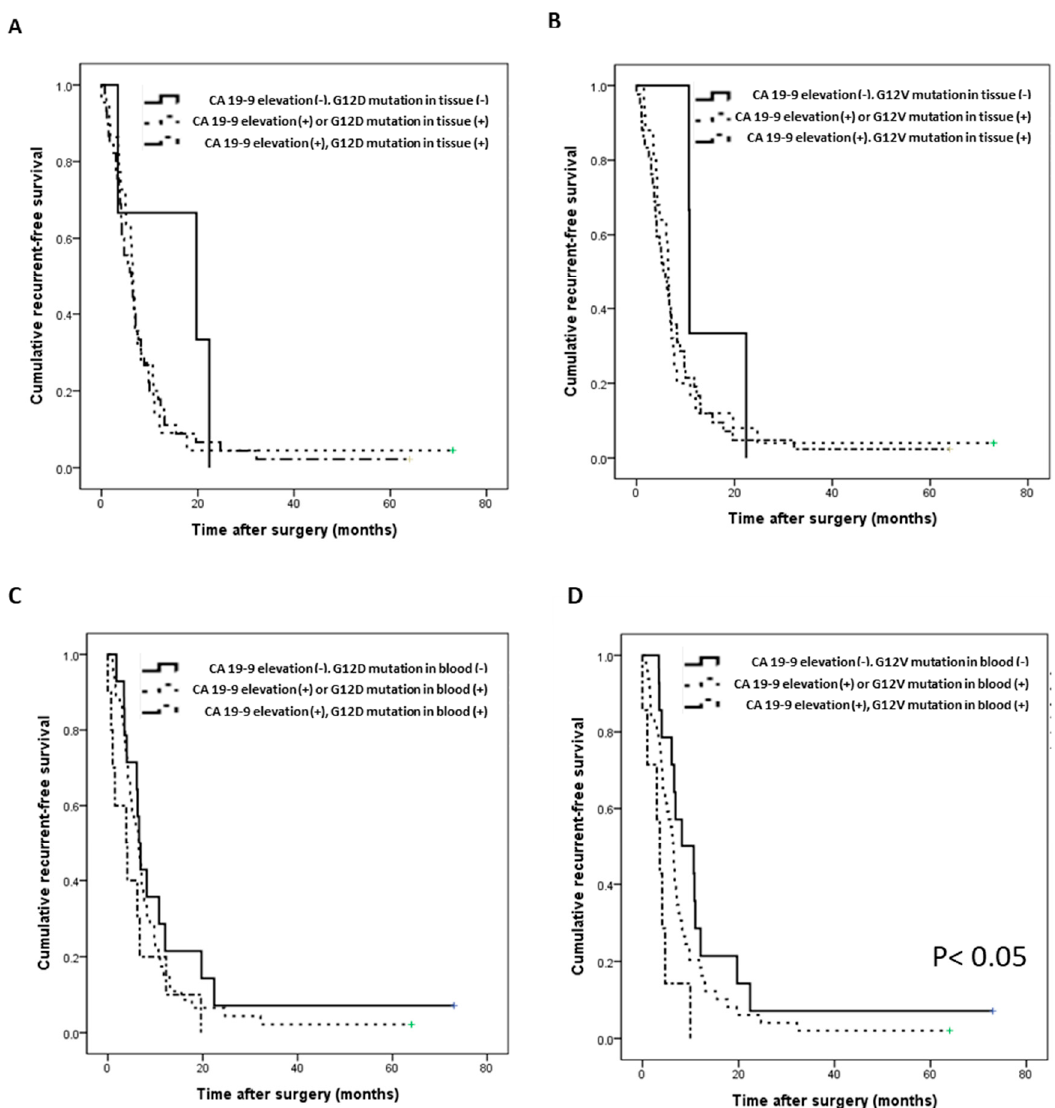
Figure 4. Correlation of the recurrence-free survival (RFS) with the G12D/V mutation and CA 19-9 ( n = 70). ( A ) RFS according to the combination of the G12D mutation and the CA 19-9 level in tissue. ( B ) RFS according to the combination of the G12V mutation and the CA 19-9 level in tissue. ( C ) RFS according to the combination of the G12D mutation and the CA 19-9 level in blood. ( D ) RFS according to the combination of the G12V mutation and the CA 19-9 level in blood ( p =